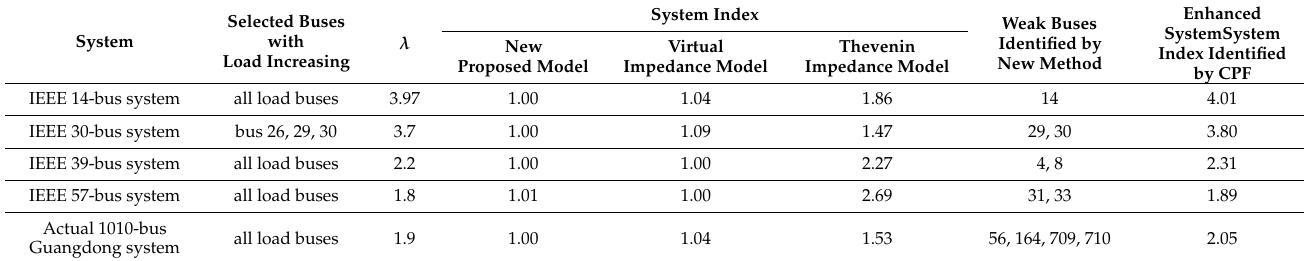
Table 6. Results of voltage stability analysis for the four IEEE systems and the 1010-bus utility system before and after enhancements. Selected Buses System with